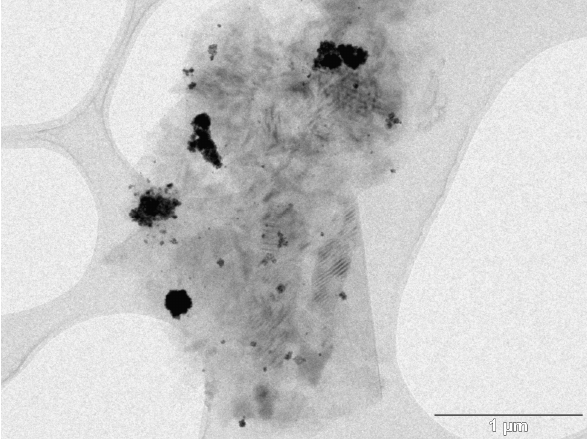
Figure 6. Transmission electronic microscopy (TEM) image of G ‐ COOH ‐ Pd ‐ 10 after five consecutive catalytic cycles.